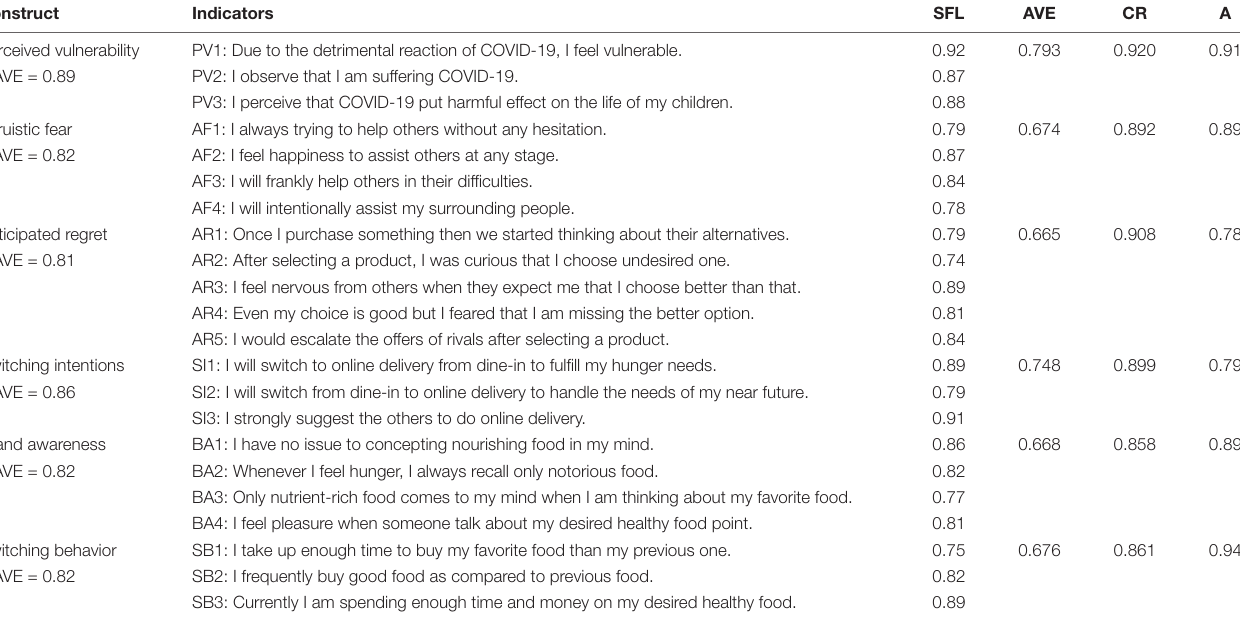
TABLE 4 | Results of confirmatory factor analysis. Construct Indicators Perceived vulnerability